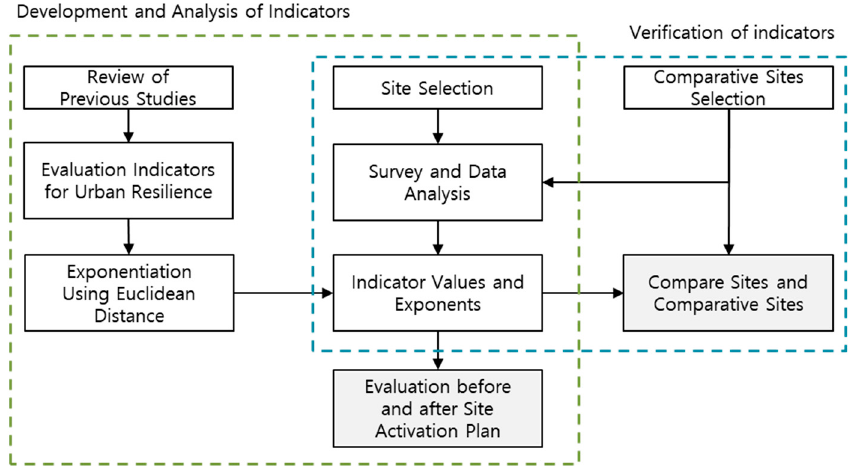
Figure 1. The research